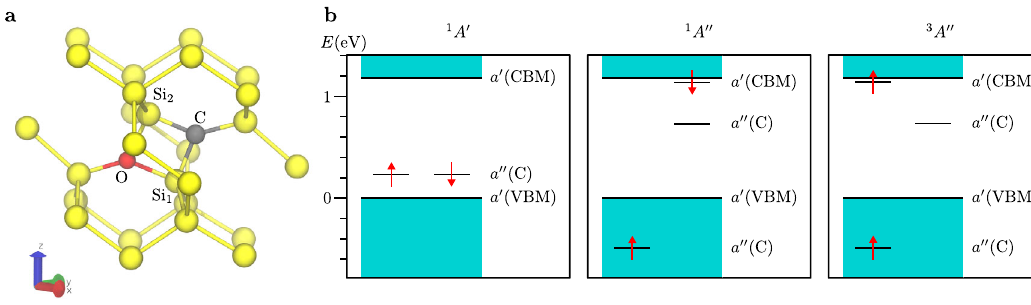
Fig. 1 Geometry and electronic structure of the defect. a The atomic structure of the C i O i defect complex, consisting of neighbouring carbon (C i − Si 1 ) and oxygen (O i − Si 2 ) split-interstitial defects. b Kohn – Sham level structure of the C i O i0 defect ground state ( 1 A 0 ), singlet ( 1 A ″ ), and triplet ( 3 A ″ ) excited states in the spin-polarised HSE06 calculation. VBM, CBM, and C labels show the valence band maximum, the conduction band minimum and the dangling bond orbital of the carbon atom,